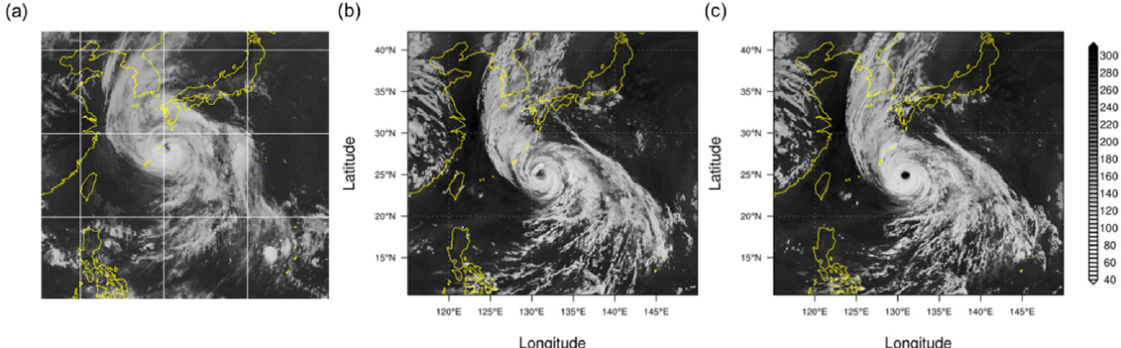
Figure 4. ( a ) Satellite infrared (IR) image (available at https://tropic.ssec.wisc.edu/#SPECIAL (accessed on 28 April 2020)) and simulated outgoing longwave radiation (W m − 2 , shading; OLR) in the ( b ) HY and ( c ) OI runs for typhoon Haishen at 00 UTC 6 September 2020.